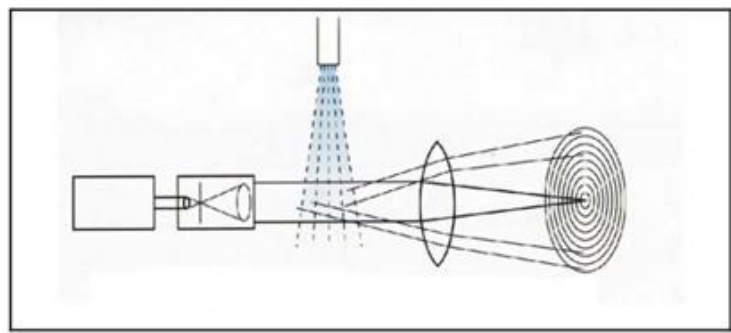
Figure 3. Schematic diagram of the laser smoke concentration tester.